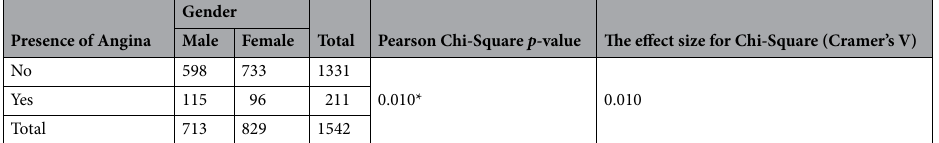
Table 6. Cross-tabulation for the presence of angina vs gender and chi-square test result (n = 1542). *Significant.